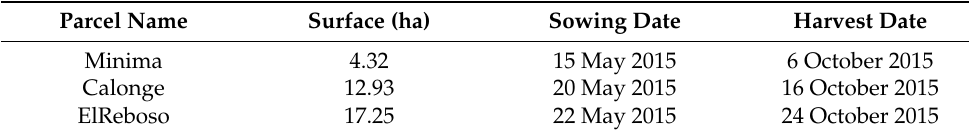
Table 1. Description of three test plots.